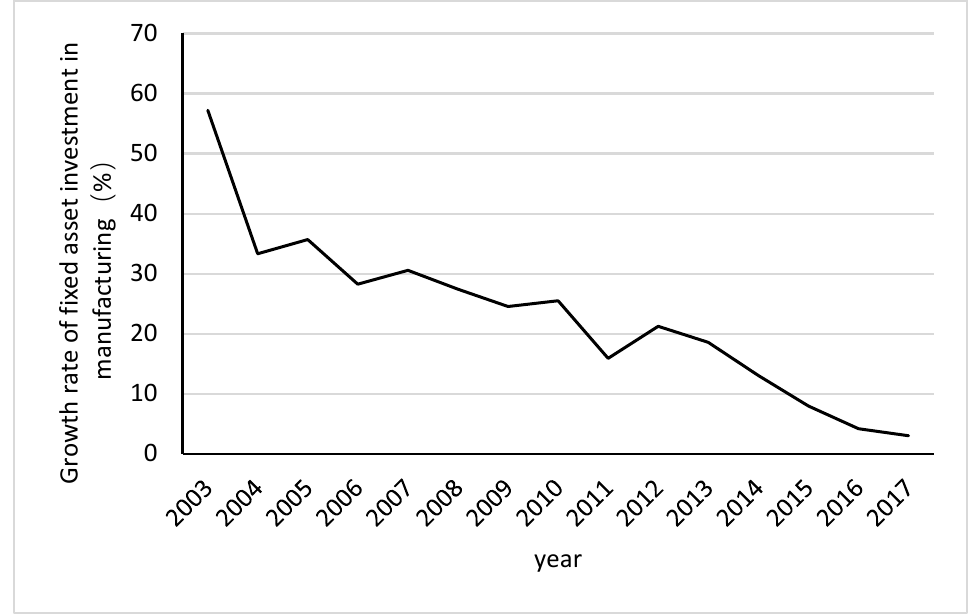
Figure 4. Growth rate of fixed assets investment in China’s manufacturing 4 .